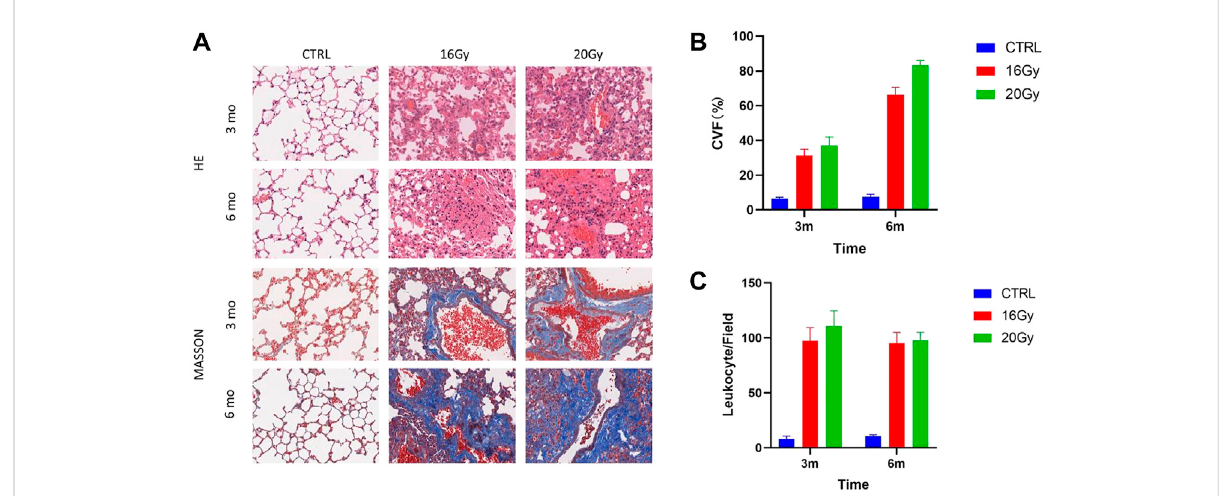
FIGURE 1 Lung remodeling after thoracic radiation. Thirty mice were randomized into 3 groups: Control group, low-dose irradiation (16 Gy) group and high-dose irradiation (20 Gy) group. Lung tissues were harvested at 3 and 6 months after radiation, for histological identi fi cation. (A) HE and Masson staining of mouse lung tissues. (B) Quanti fi cation of septal thickness by analysis of collagen volume fraction. Septal thickness increased at 3 months after radiation and elevated further at 6 months after thoracic irradiation. (C) Quanti fi cation of leukocyte in fi ltration. Leukocyte in fi ltration was signi fi cantly increased in the radiation groups. CVF, collagen volume fraction; CTRL, control group.